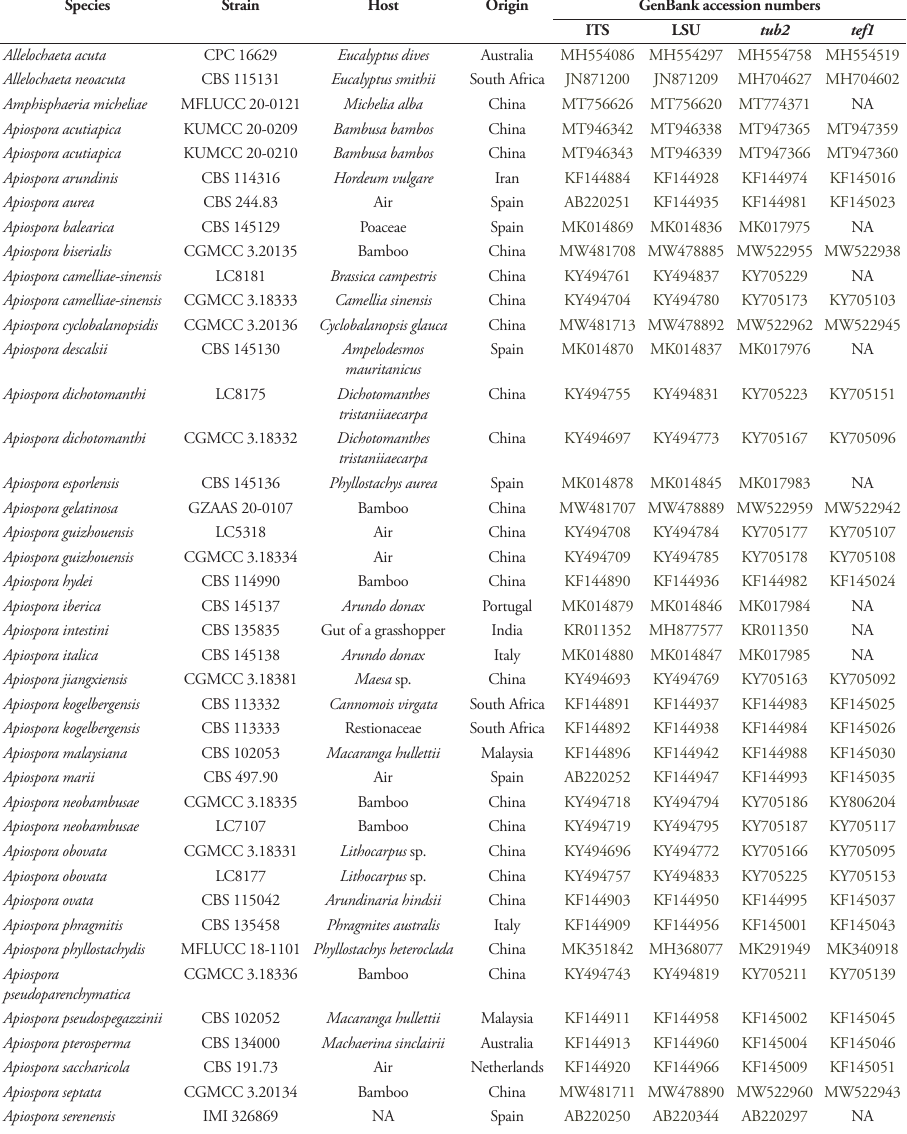
Table 1. Isolates and GenBank accession numbers used in the phylogenetic